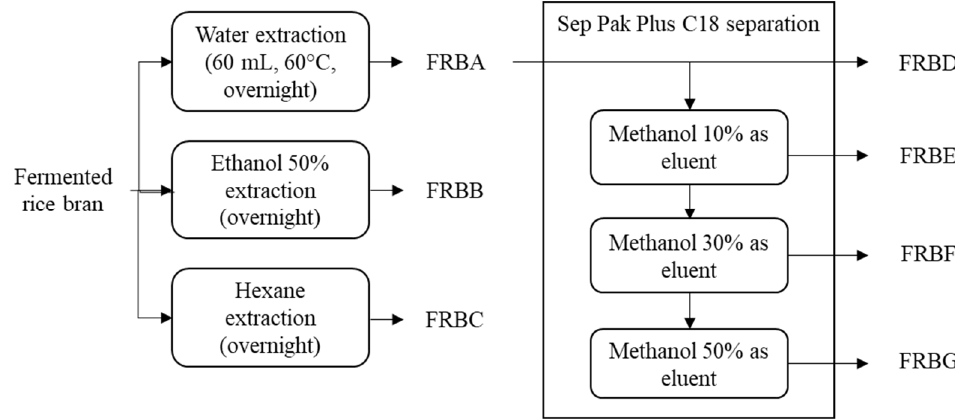
Figure 7. Scheme of the current experimental design.